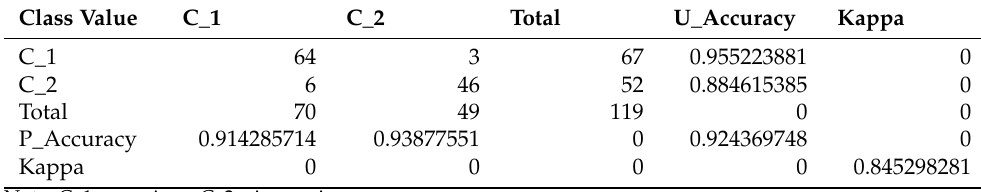
Table 7. Confusion Matrix (RT method).